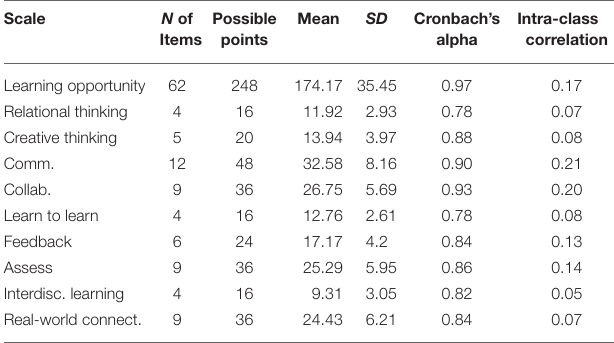
TABLE 1 | Demographics of sample aggregated across schools. Variable